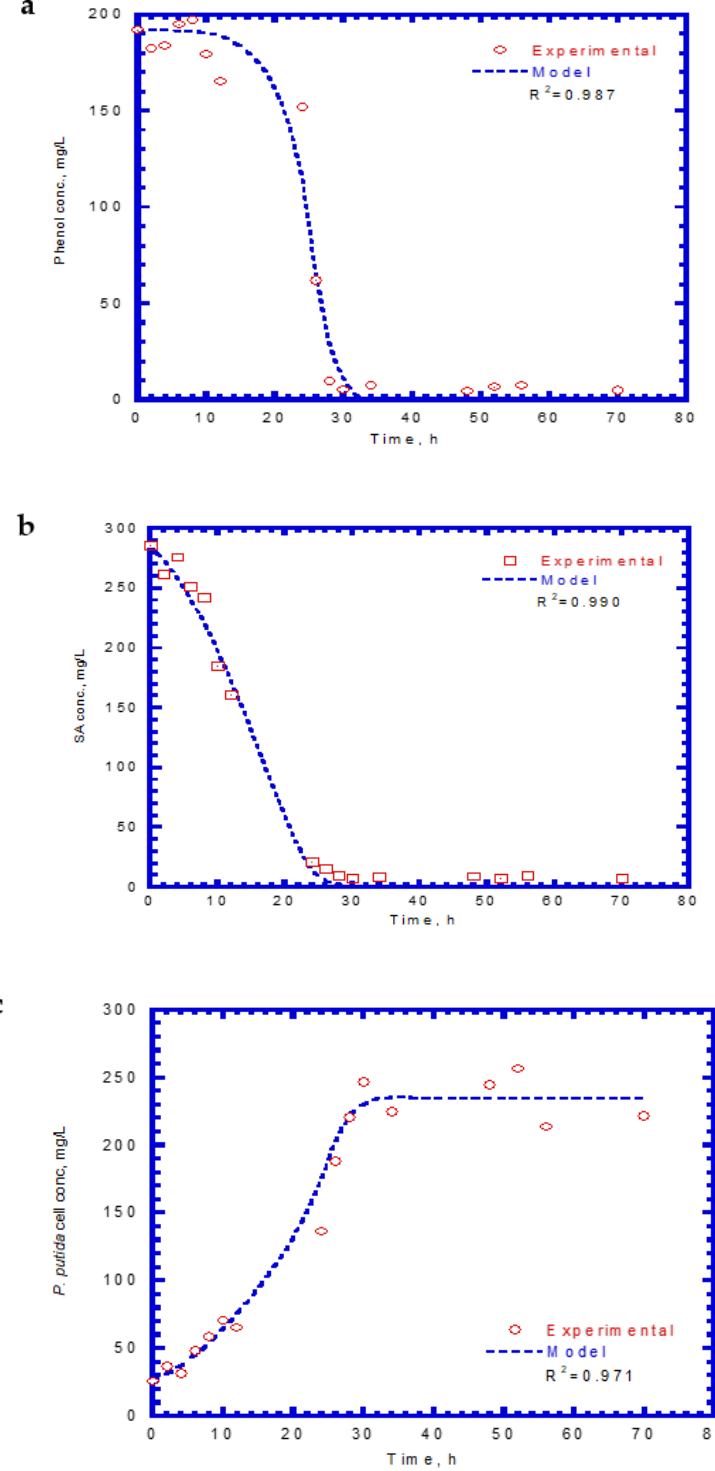
Figure 10. Effluent concentration of phenol plus SA in the chemostat system: ( a ) phenol, ( b ) SA, and ( c ) cell growth.